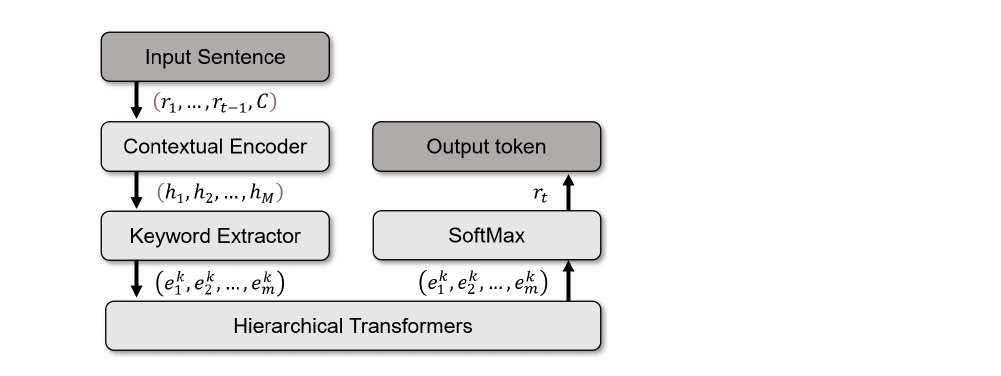
Figure 2. Overview of the proposed approach and output for keyword-aware dialog generation. The outputs of each module are provided in the boxes below their corresponding